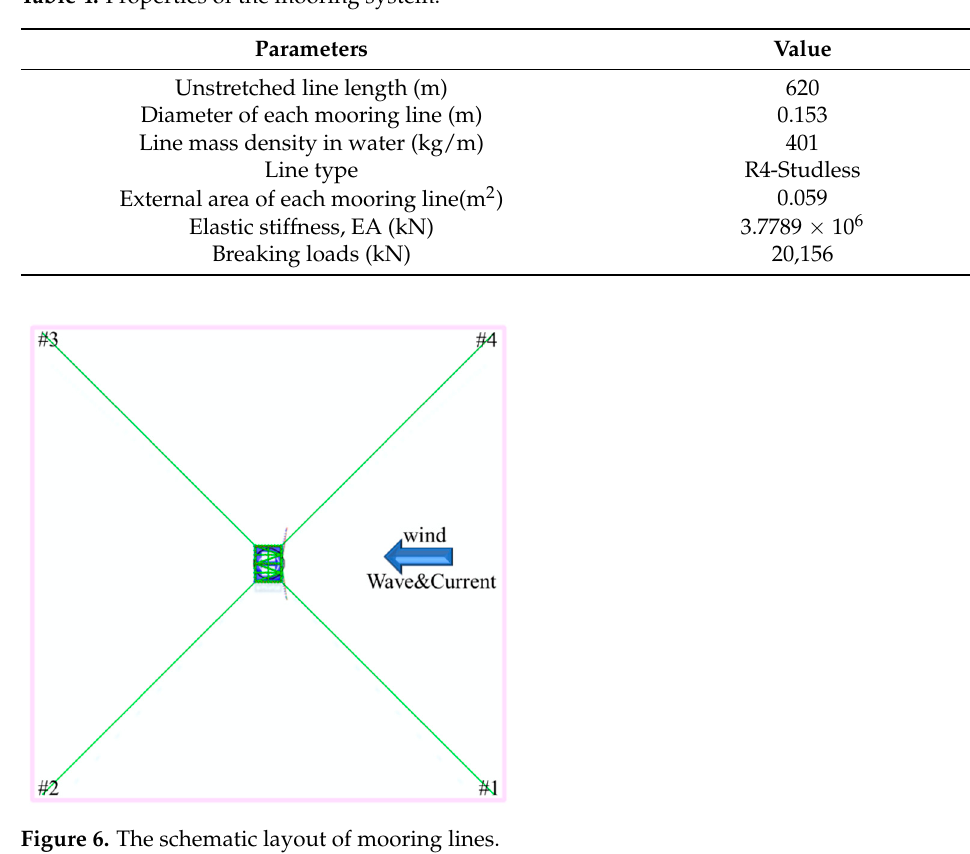
Figure 5. The wind heeling moment and righting moment of LSBT-FOWT-AC. Table 4. Properties of the mooring system.